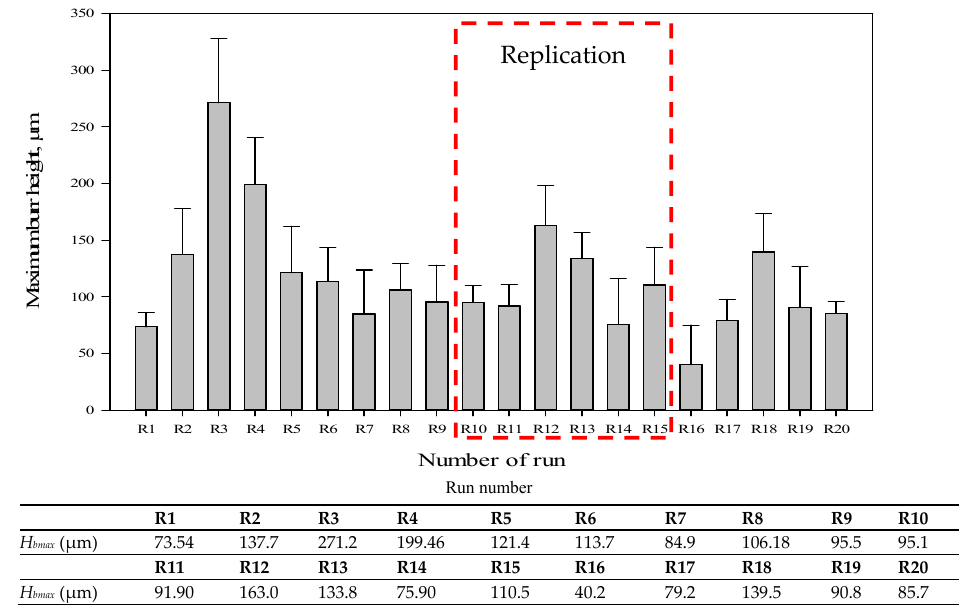
Figure 13. Burr formation data during all 20 runs.